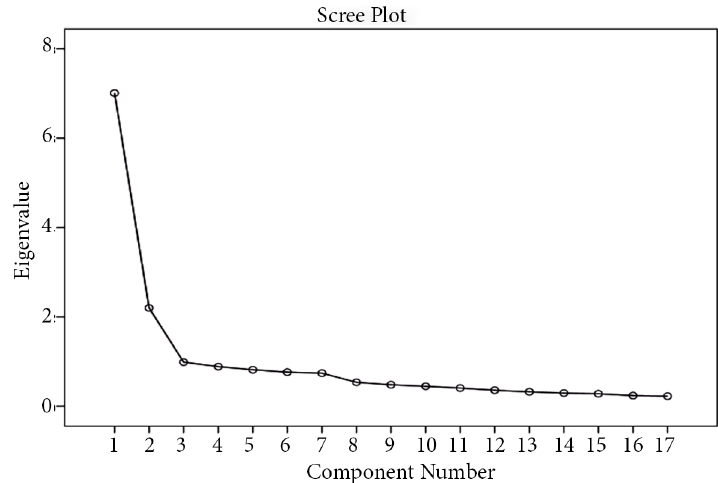
Figure 1. Extracted factor structure of the BOSS